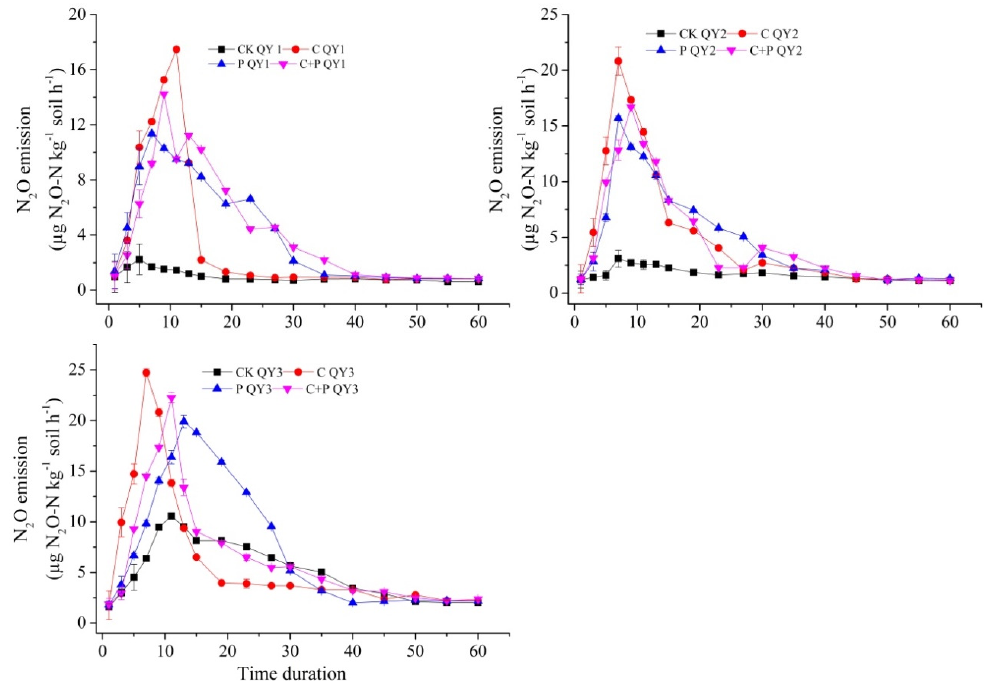
Figure 1. N 2 O emission rates from phosphorus-deficient (QY1) and phosphorous-adequate soils (QY2, QY3) with and without glucose (Glu) addition during the incubation period. Gas emission rates are in log scale. CK: control; C, glucose addition; P, phosphorus addition; C + P, glucose and phosphorus addition. Error bars represent standard error (n = 3). Note: phosphorus-deficient soil is represented by QY1 and phosphorus-adequate soils are denoted by QY2 and QY3.